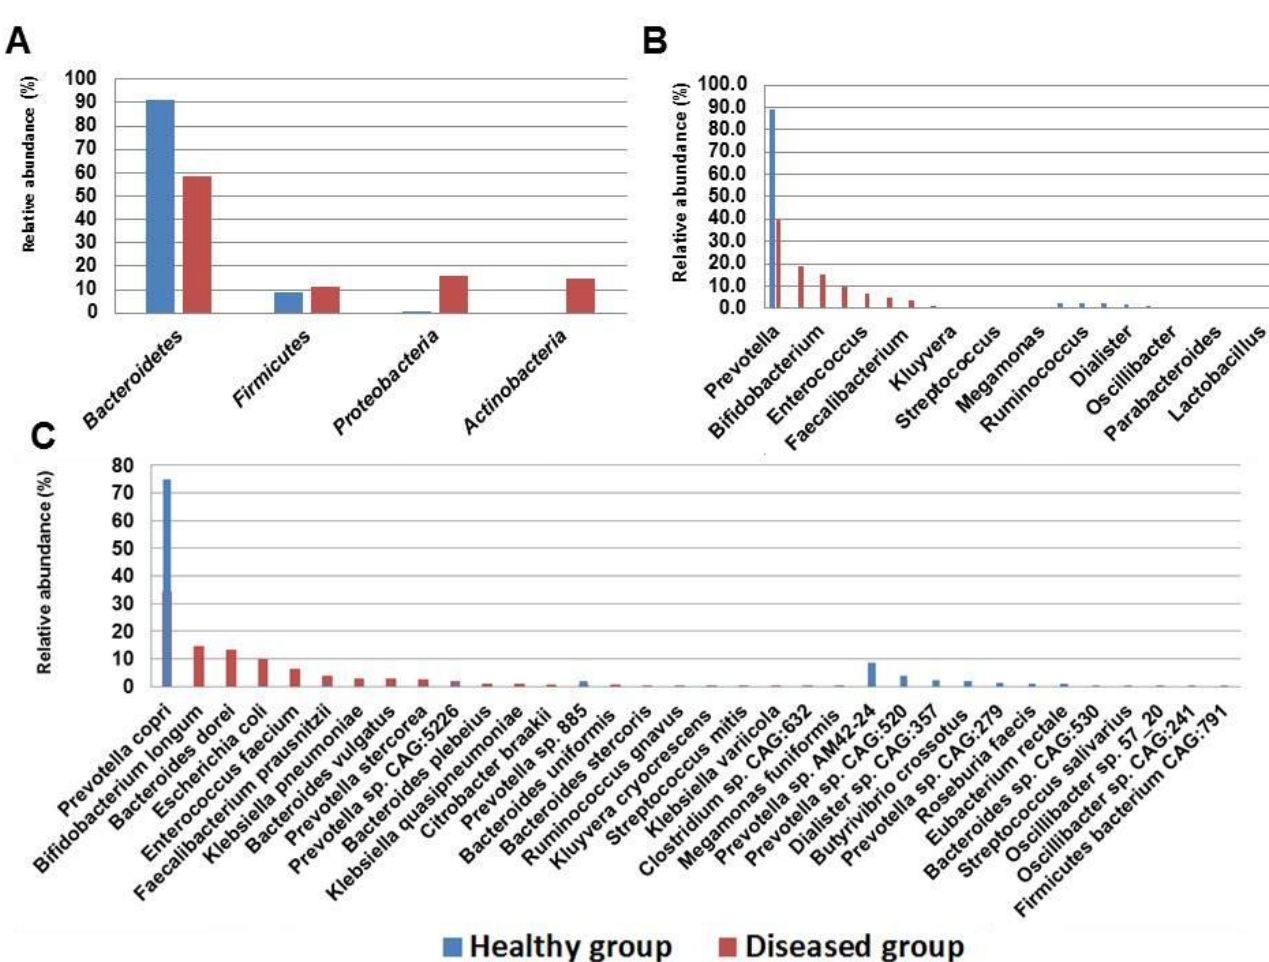
Figure 1. Taxonomic profiling of fecal microbiome in healthy and diseased subjects at various levels. Relative abundance of fecal microflora of healthy and diseased subjects at phylum level ( A ), genus level ( B ), and species level ( C ).